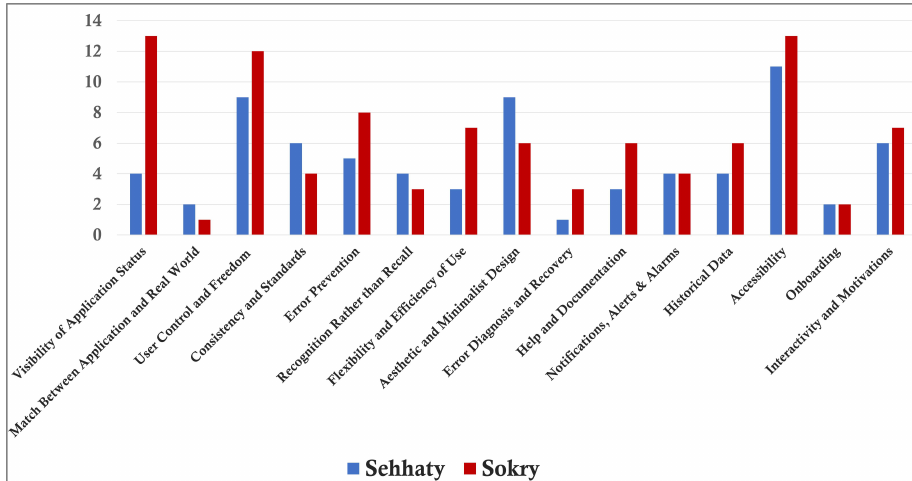
Figure 6. Number of usability problems found by